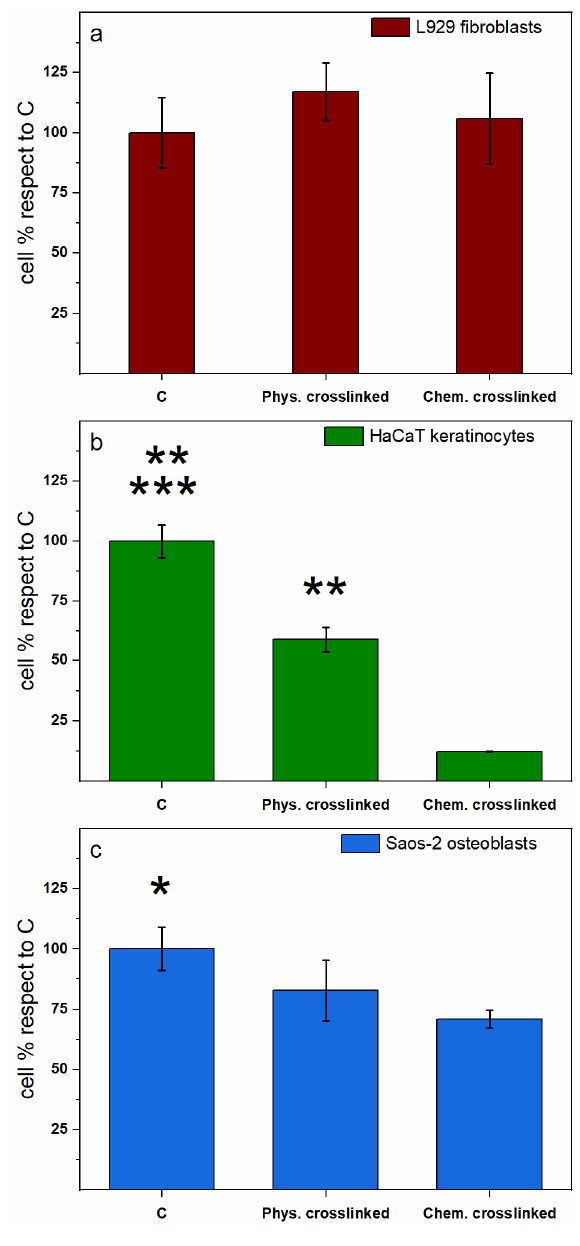
Figure 6. Cell toxicity, measured by MTT test, of conditioned culture media obtained by soaking the membranes for 24 h in sterile conditions at 37 °C and then adding the media diluted 1:1 to L929 murine fibroblasts ( a ), HaCaT human keratinocytes ( b ) or Saos-2 human osteoblasts ( c ) for further 24 h. Results are expressed as percentages respect to control, untreated cells and are the mean ± S.D. of 3 experiments performed in quadruplicate. The asterisk indicates significance in T -test (panel b : ** p < 0.0005 C vs. Phys-cross and Phys-cross vs. Chem-cross, *** p < 0.0001 C vs. Chem-cross, panel c : * p < 0.005 C vs. Chem-cross).